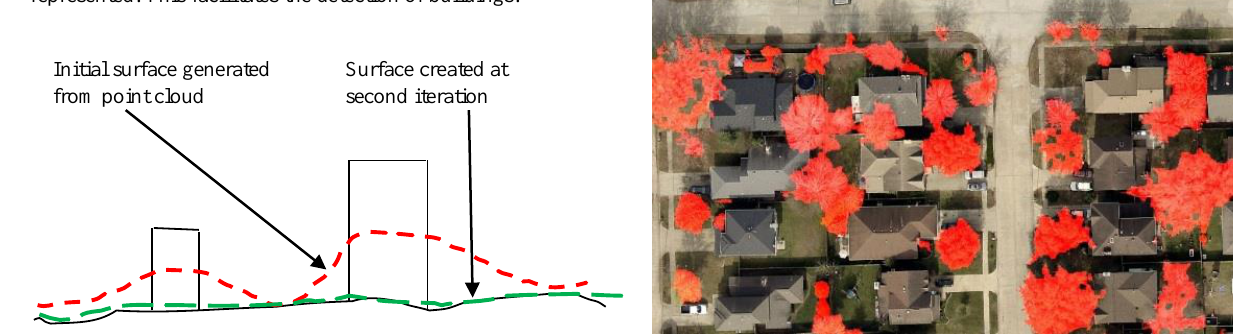
Figure 4 Automatically Detected